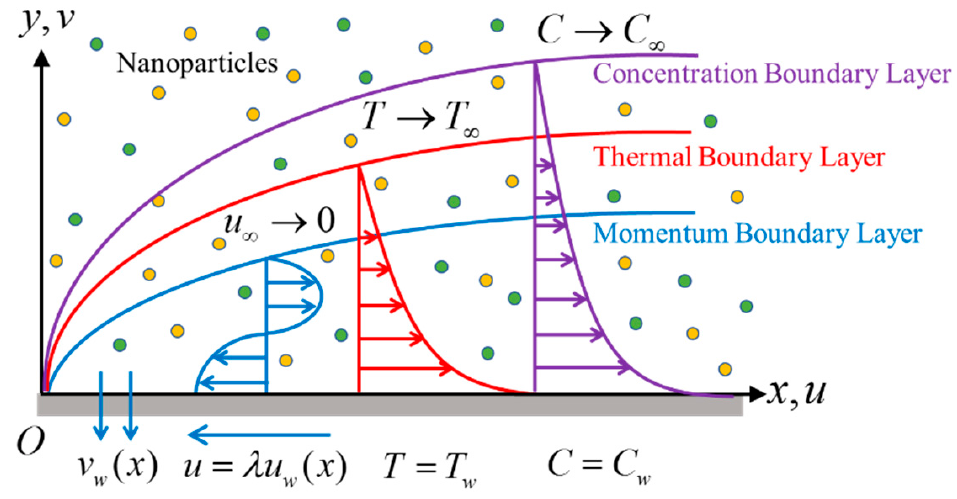
Figure 1. Physical flow configuration.